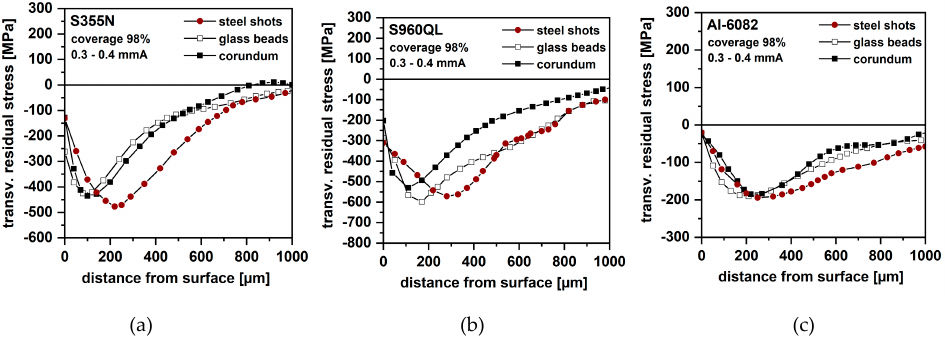
Figure 4. Residual stress in the surface layer obtained at the weld toes by means of hole drilling method. DV-butt welds made from S355N ( a ), S960QL ( b ), and Al-6082 ( c ).